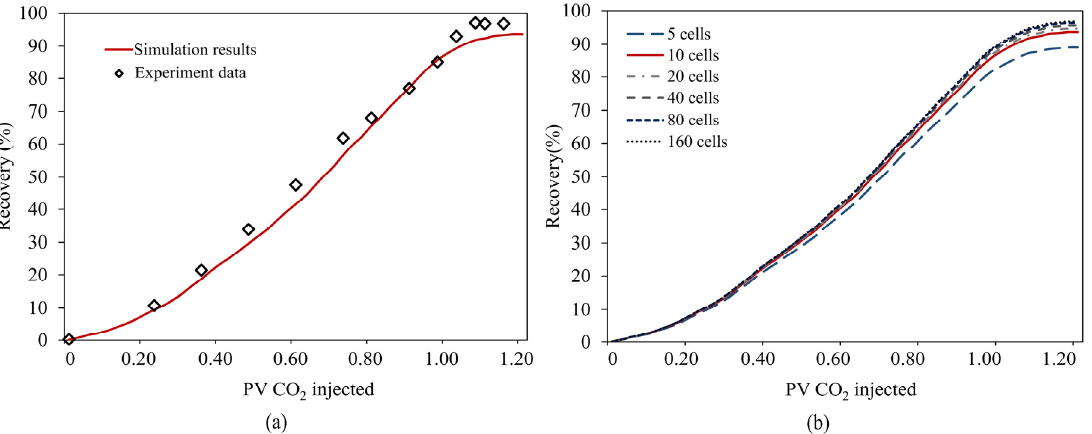
Figure 2. The ( a ) comparison of simulation results with experimental data, ( b ) comparison of recov-